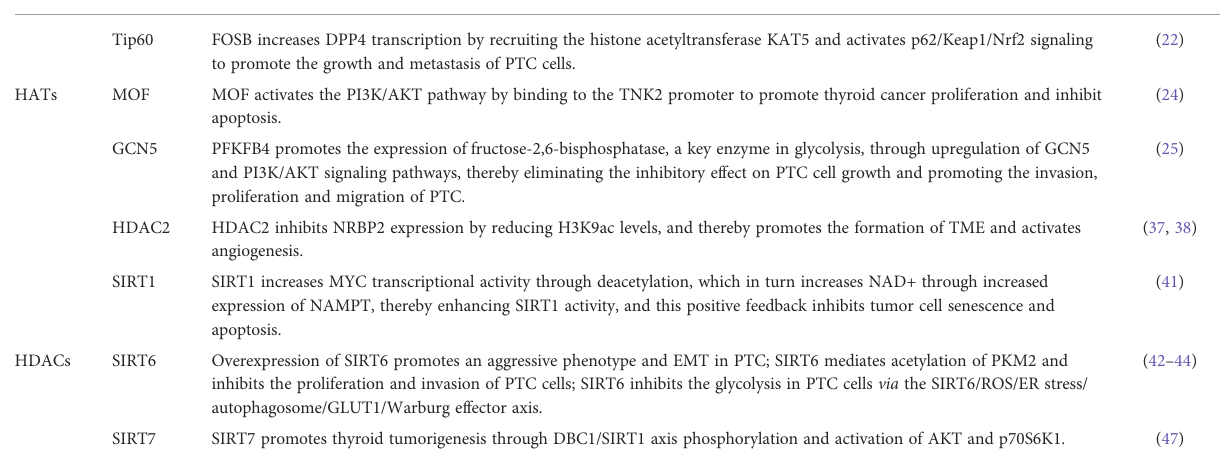
TABLE 1 Histone acetylase and histone deacetylase studies in PTC. Enzymes